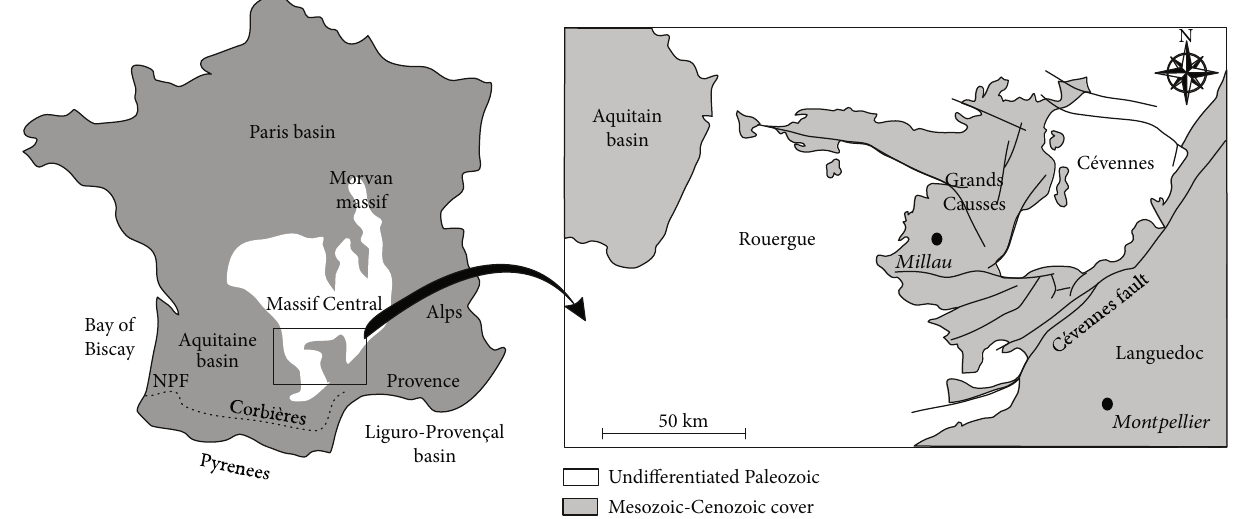
Figure 1: Localization of the studied area. NPFT: north Pyrenean frontal